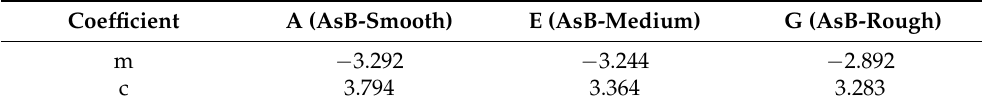
Table 7. Coefficients of logarithmic-linear equation lg ( N ) = m · lg ( σ ) + c for three surface conditions. Coefficient